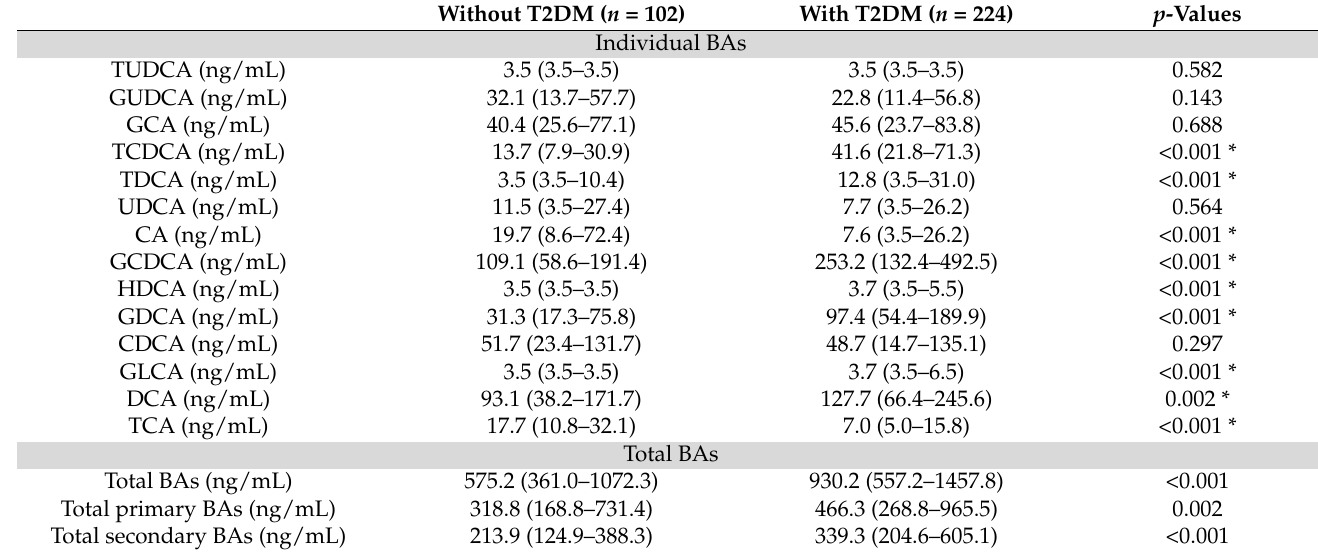
Table 2. Plasma bile acid concentrations in patients stratified by presence or absence of type 2 diabetes